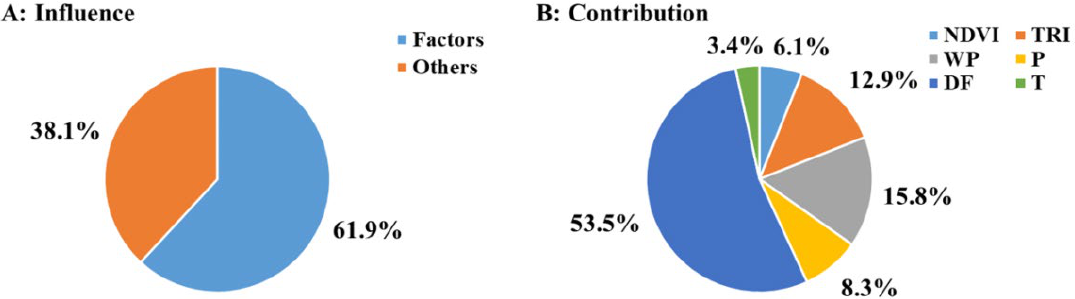
Figure 6. Different factors’ influence ( A ) and contribution ( B ) to heavy metal content in soil. The results of the OLS regression analysis demonstrated that the six selected factors only influenced the heavy metal content of the soil by 61.9%, indicating the relevance of the other factors. Possible factors include locomotive exhaust from mineral transportation,